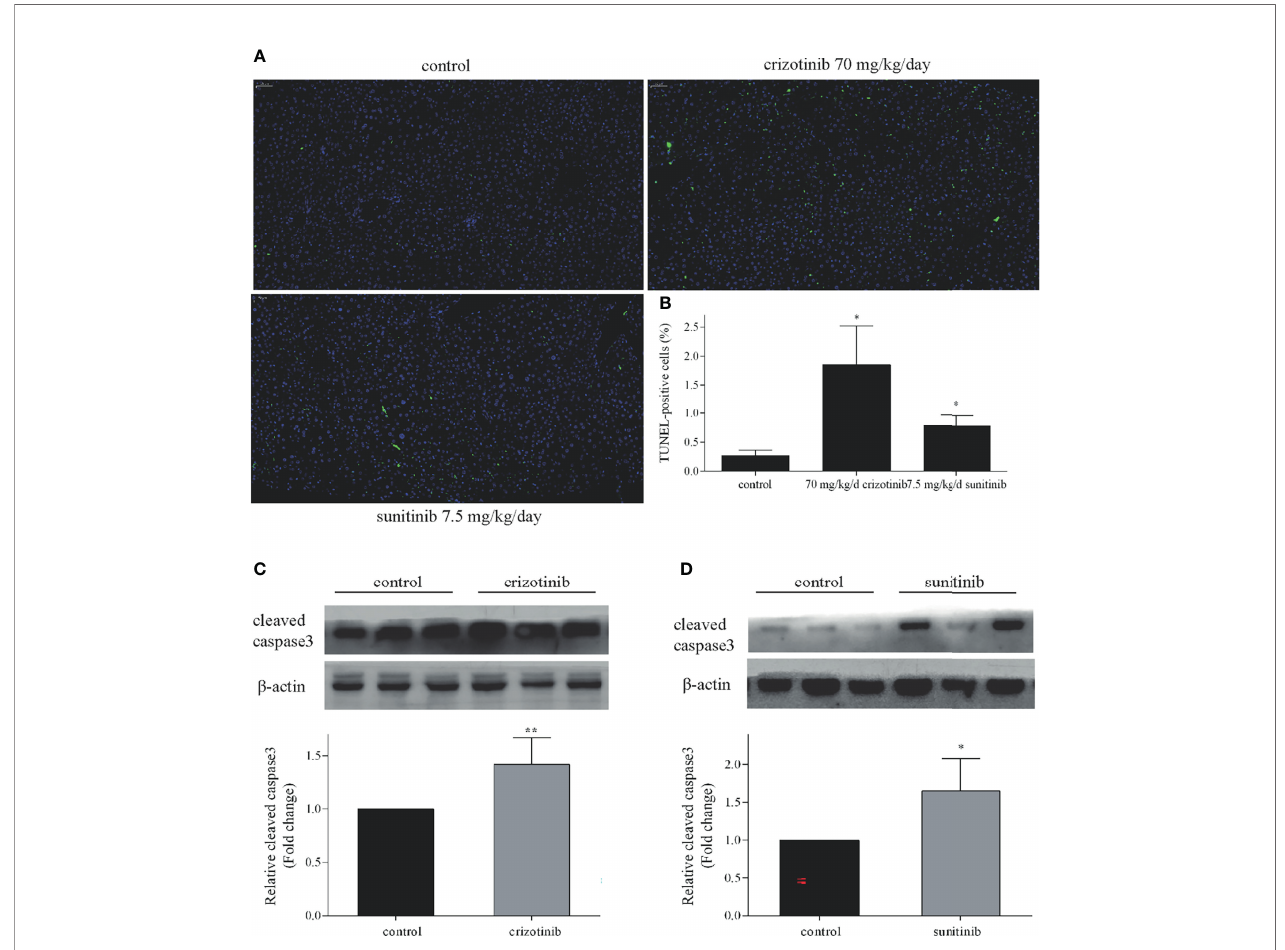
FIGURE 4 | Crizotinib and sunitinib induced apoptosis in vivo . (A) The ICR mice hepatocyte apoptosis in liver tissue (TUNEL, 20×). The blue fl uorescence indicates nuclei, and the green fl uorescence indicates apoptotic cells. (B) TUNEL-positive cells were quanti fi ed. (C, D) The protein expression of cleaved caspase 3 in ICR mice treated with vehicle, crizotinib, or sunitinib treatment (n = 6). *P < 0.05 or **P < 0.01 (the crizotinib or sunitinib alone vs.